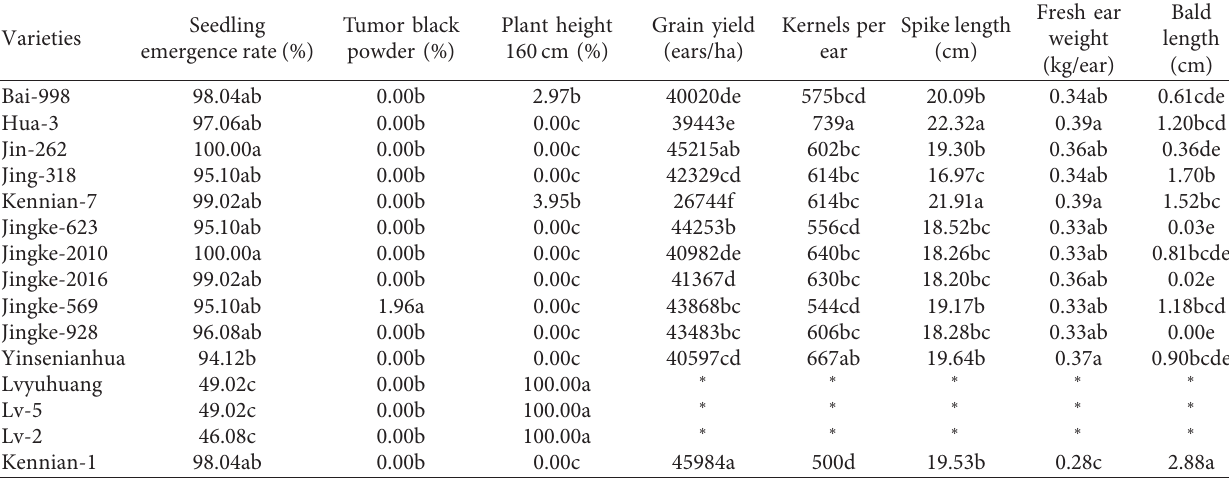
Table 2: Growth and yield of waxy maize during 2017.